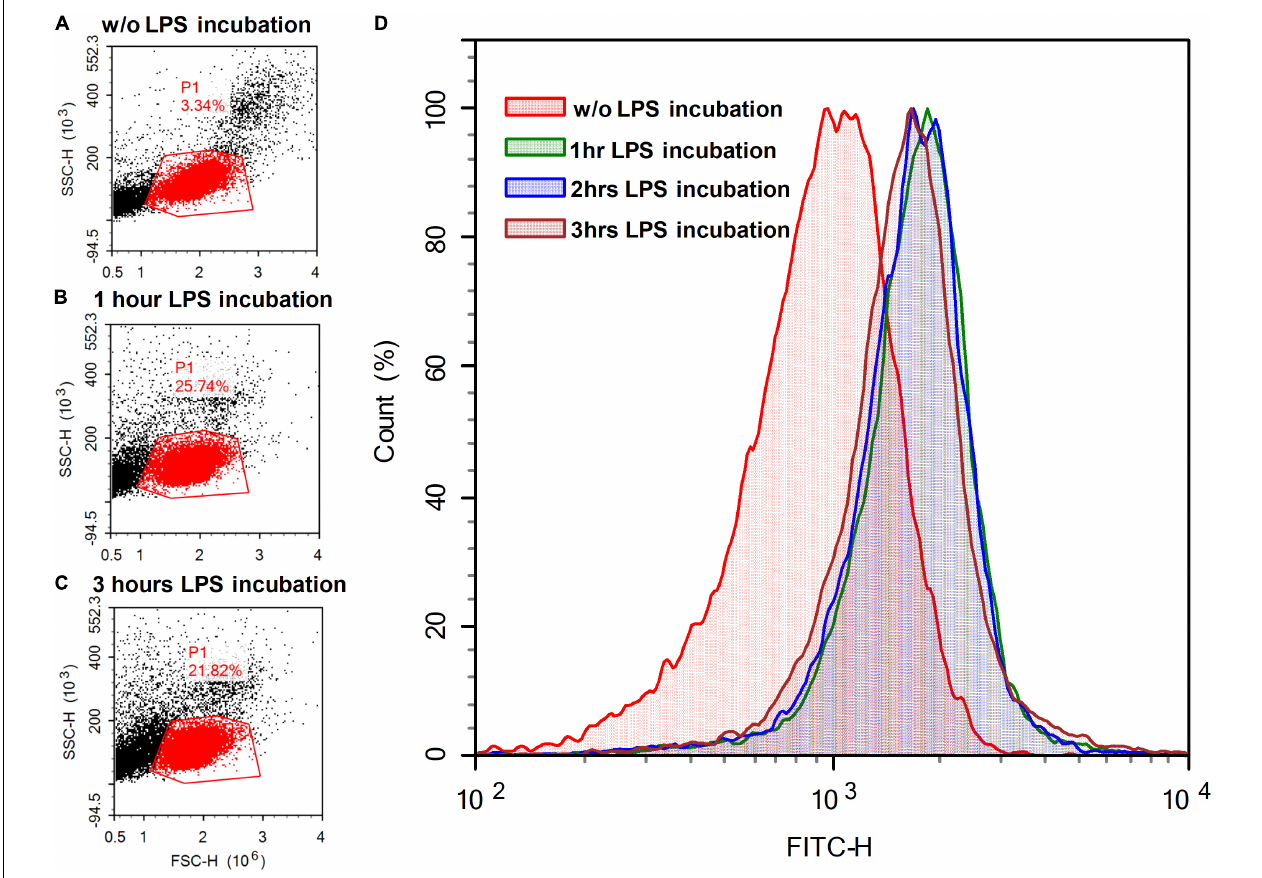
FIGURE 9 | Light scattering (left column of panels) and fluorescent signals (right panel) of lymphocyte suspension (A) without (w/o) the addition of fluorescently labeled LPS analog (BDP-LPS) and after (B) one and (C) 3 h of incubation with BDP-LPS (10 µ g/ml). The scattering of laser light (488 nm) in the direction of the beam propagation (FSC-H) and in the perpendicular direction (SSC-H) was recorded for cell selection. Events that had light scattering parameters typical for lymphocytes (gate P1 area) were accumulated (15,000 events) and graphs of the distribution of fluorescent cells were plotted (D) (fluorescence was monitored at 535 ± 15